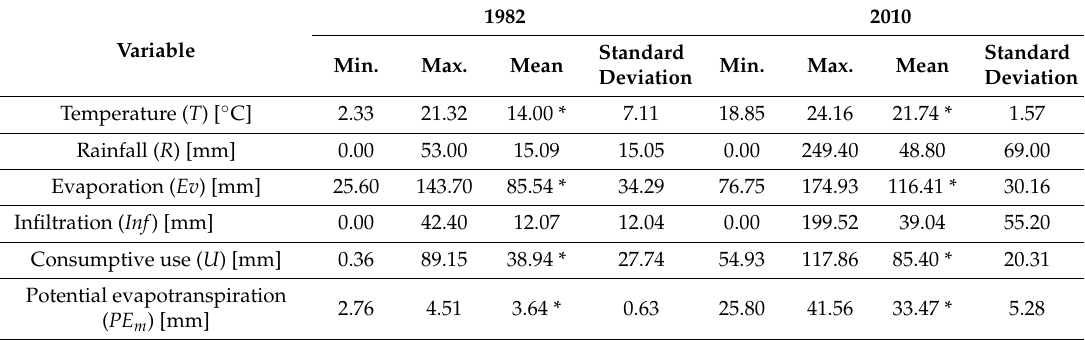
Table 2. Descriptive analysis of the monthly hydrological variables corresponding to 1982 and 2010.